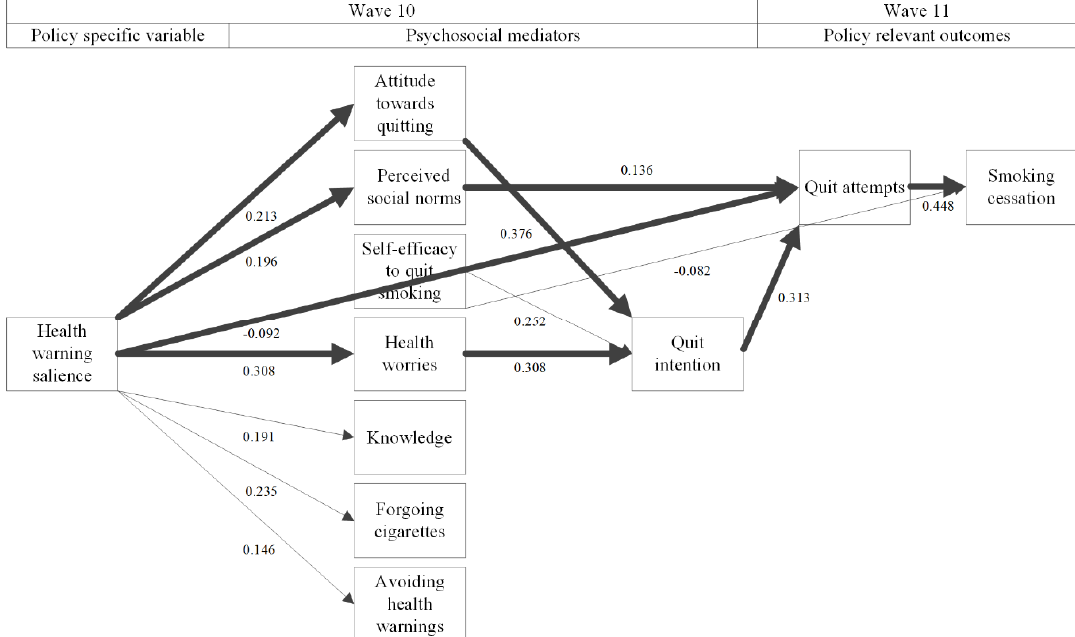
Figure 3. Structural equation model with standardized regression coefficients for the analysis of complete cases. Thick lines represent significant pathways between health warning salience and smoking cessation; thin lines represent significant associations that are not part of a significant mediational pathway; no lines between variables denote non-significant associations between them. All psychosocial mediators that are in the second column from the left were allowed to